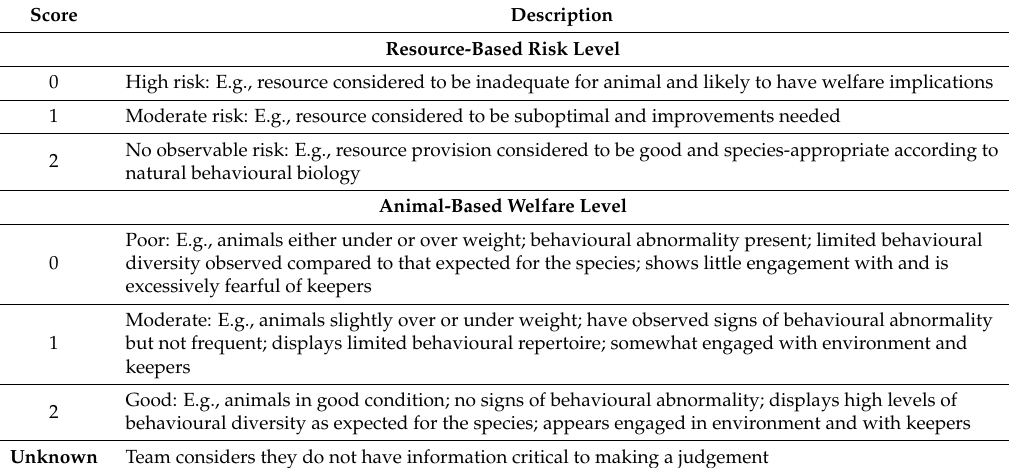
Table 2. Outline of the scoring process. ‘Unknown’ can be assigned for either resource-based risks or animal-based